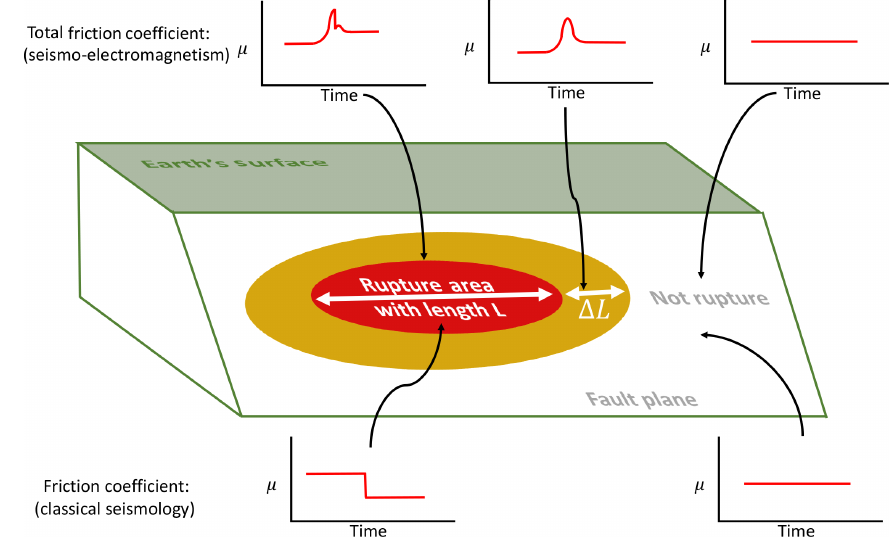
Figure 6. Schematic comparison among different friction behaviors related to seismic rupture area. At the top the result of friction in the context of the seismo-electromagnetic theory is presented. At the bottom the classical view of the friction is presented. When the rupture occurs, a friction drop is observed in the two theories. However, a friction increase exists in the case studied in this work.